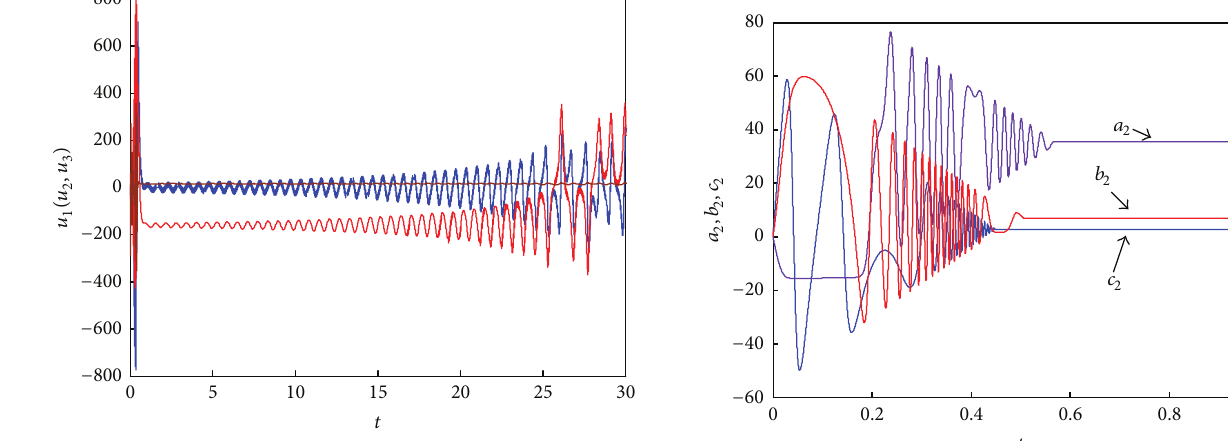
Figure 7: The estimated value of the unknown parameters 𝑎 2 , 𝑏 2 , and 𝑐 2 in the L¨u